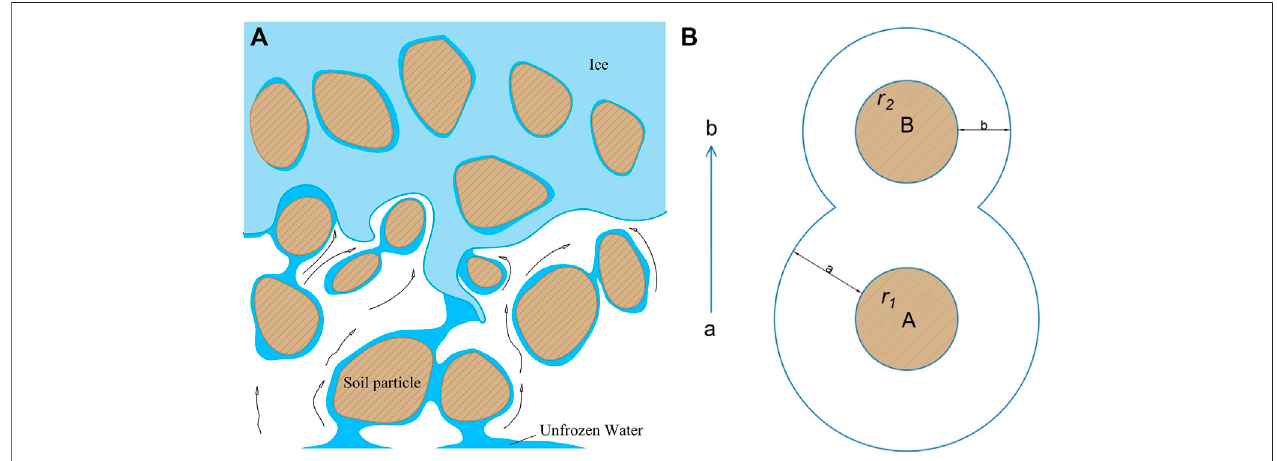
FIGURE3| Aschematicdiagramof fi lmwatermigration: (A) thedirectionof fi lmwatermigration; (B) theprincipleof fi lmwatermigrationaroundsoilparticles(i.e.,A and B are soil particles with equal radius, a and b are water fi lm thickness (a > b), and particle B is closer to the freezing front).